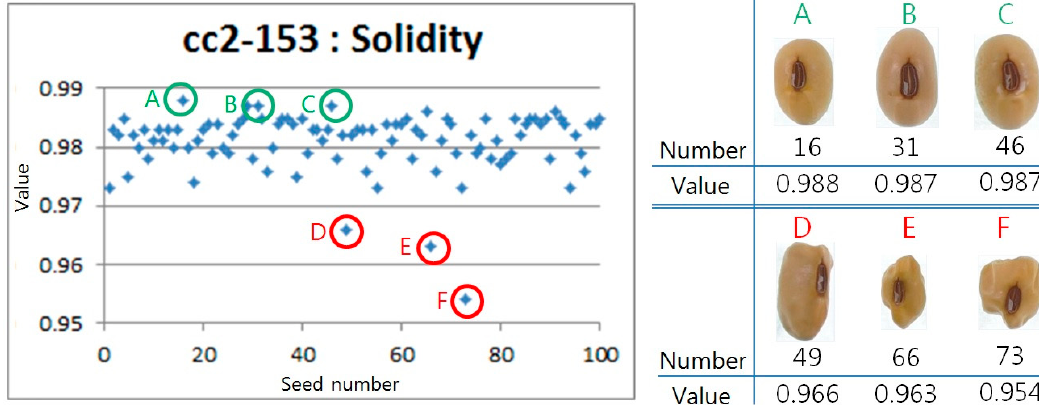
Figure 5. Detecting specific morphology using the Solidity. Good seeds are A, B, C and bad seeds are D, E, F.